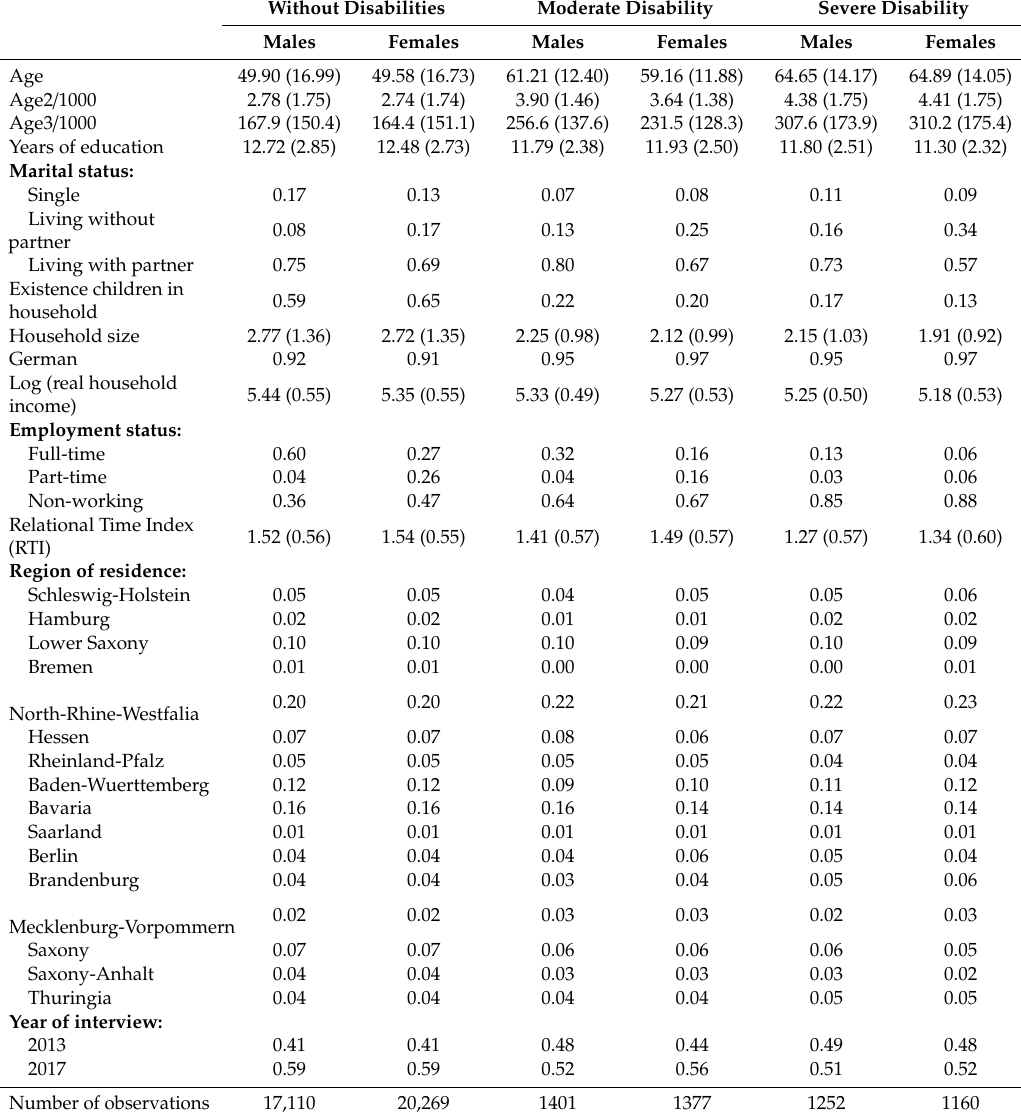
Table A1. Mean values and standard deviations (between parentheses) of explanatory variables used in Table 1 by disability status and